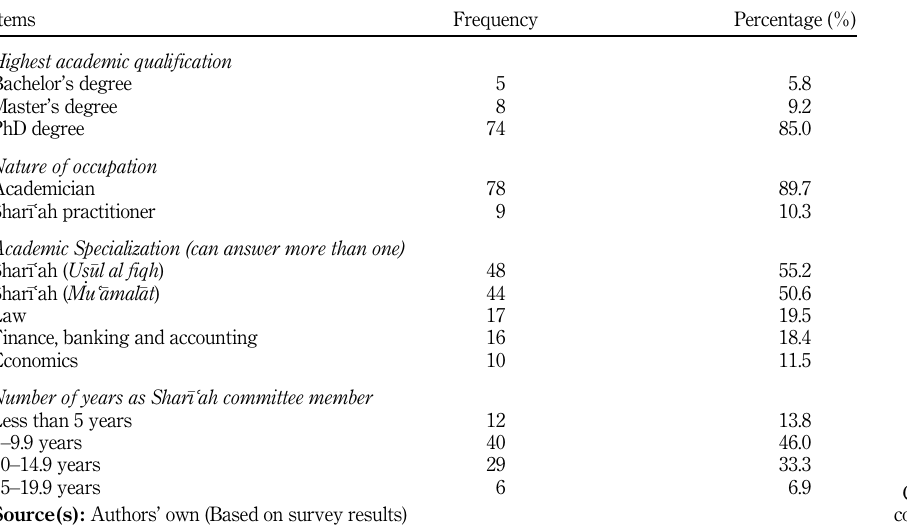
Table 2. Quality of Shar (cid:1) ı ʿ ah committee